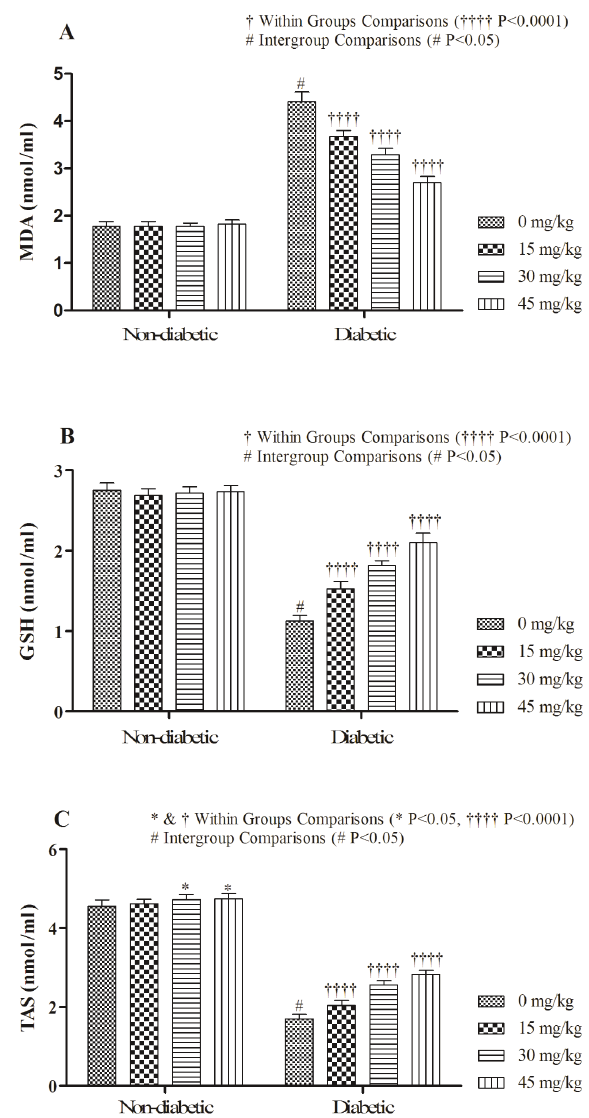
Figure 1. Effects of different levels of SN extract on antioxidant variables in diabetic and non-diabetic rats